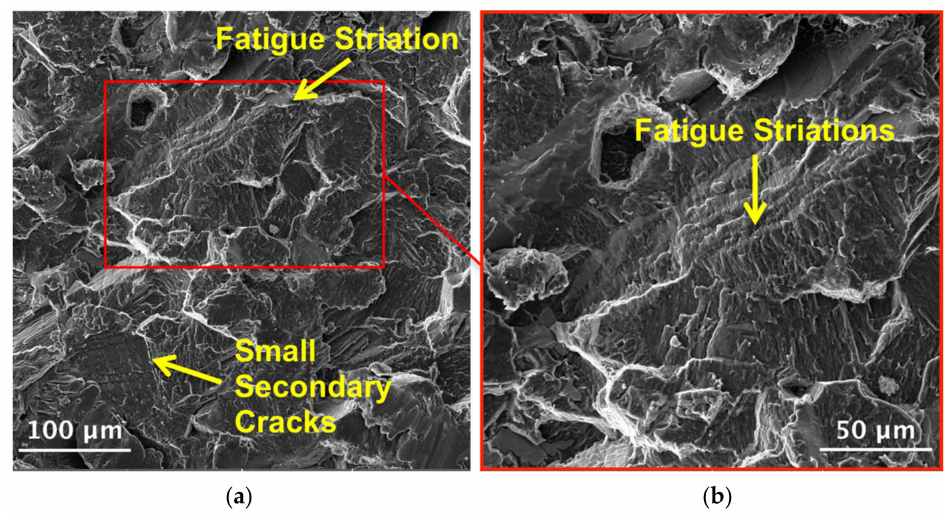
Figure 14. Fatigue tests (4-point rotating bending), fracture surface analysis: SEM images of the crack propagation region showing the typical fatigue striations and small secondary cracks ( a , b ).